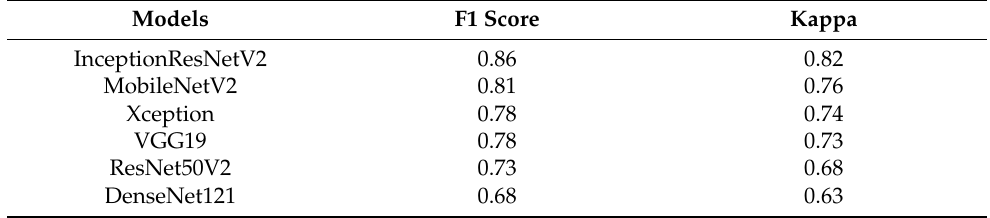
Table 2. Comparison of performance on sample prediction among six pre-trained models on Testing